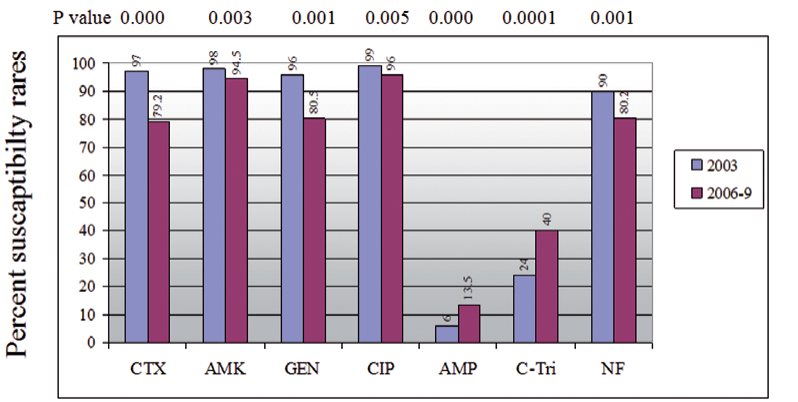
Figure 2 - Comparison between average susceptibility level of E.coli isolated during years 2006-09 with those of 2003. sensitivity levels to AMP and C-Tri decreased significantly from the years 2003